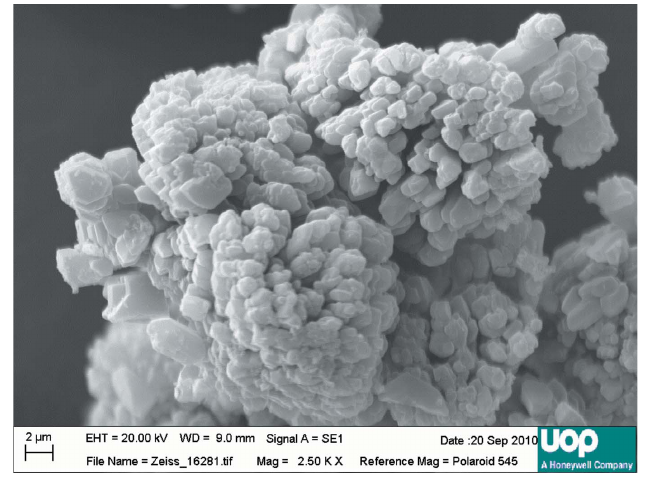
Figure 6 SEM image of polycrystalline (NH 4 ) 3 Al 2 (PO 4 ) 3 synthesized ionother- mally in ethyl tributylphosphonium diethyl phosphate and used for structure refinement.